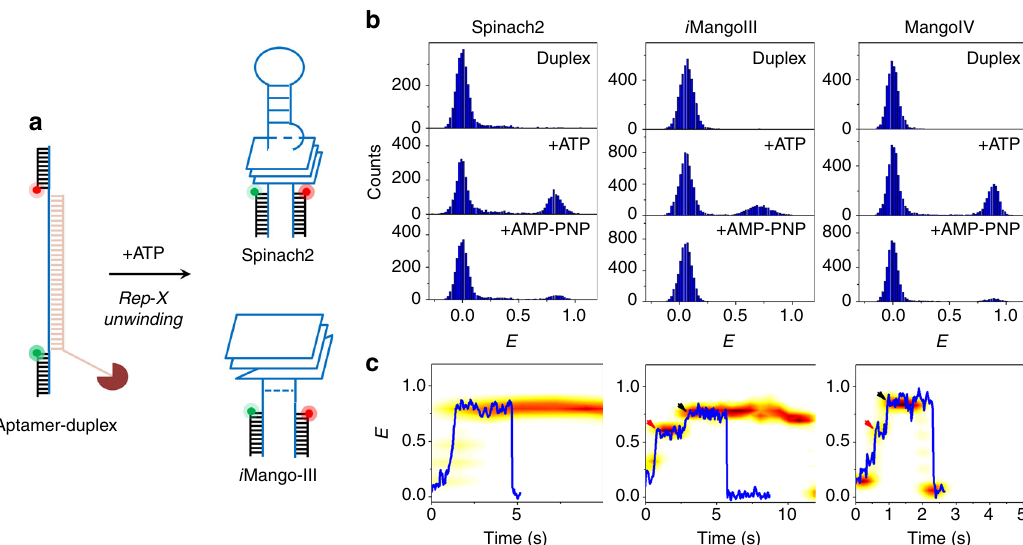
Fig. 5 Vectorial folding of “ light-up ” RNA aptamers. a Schematic of unfolding of an aptamer-heteroduplex via Rep-X and its subsequent folding (Spinach2 and i MangoIII are shown as representations here). b E histograms of heteroduplex in the Rep-X unbound (top) and after Rep-X unwinding in the presence of ATP (middle) and AMP-PNP (bottom). c Representative single-molecule trajectories (blue) showing co-transcriptional folding of an aptamer (Spinach2 (left), i MangoIII (middle), and MangoIV (right), 30 ms integration time). The red and black arrows indicate two-step RNA folding corresponding to formation of GQ (red) and the underlying base triple (black, i MangoIII) and duplex stem (black, MangoIV). Individual time trajectories have been synchronized ( “ Methods ” section) and overlaid on to the representative traces. Population information is represented as: light yellow (lowest occupancy) to red (highest